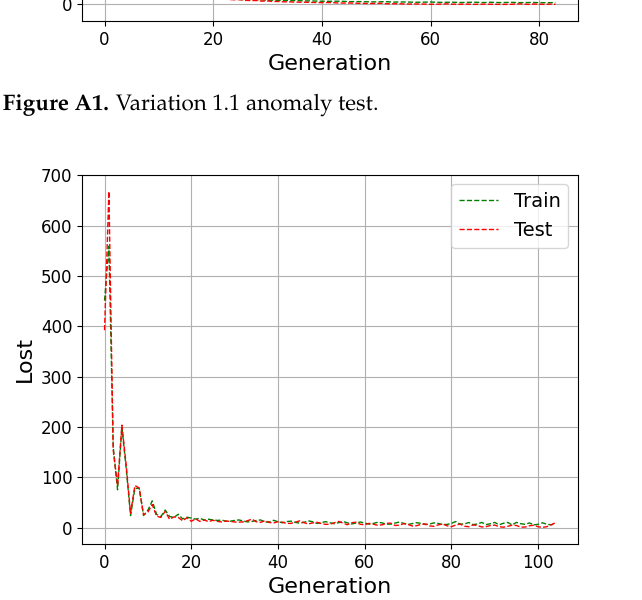
Figure A2. Variation 1.2 anomaly test.